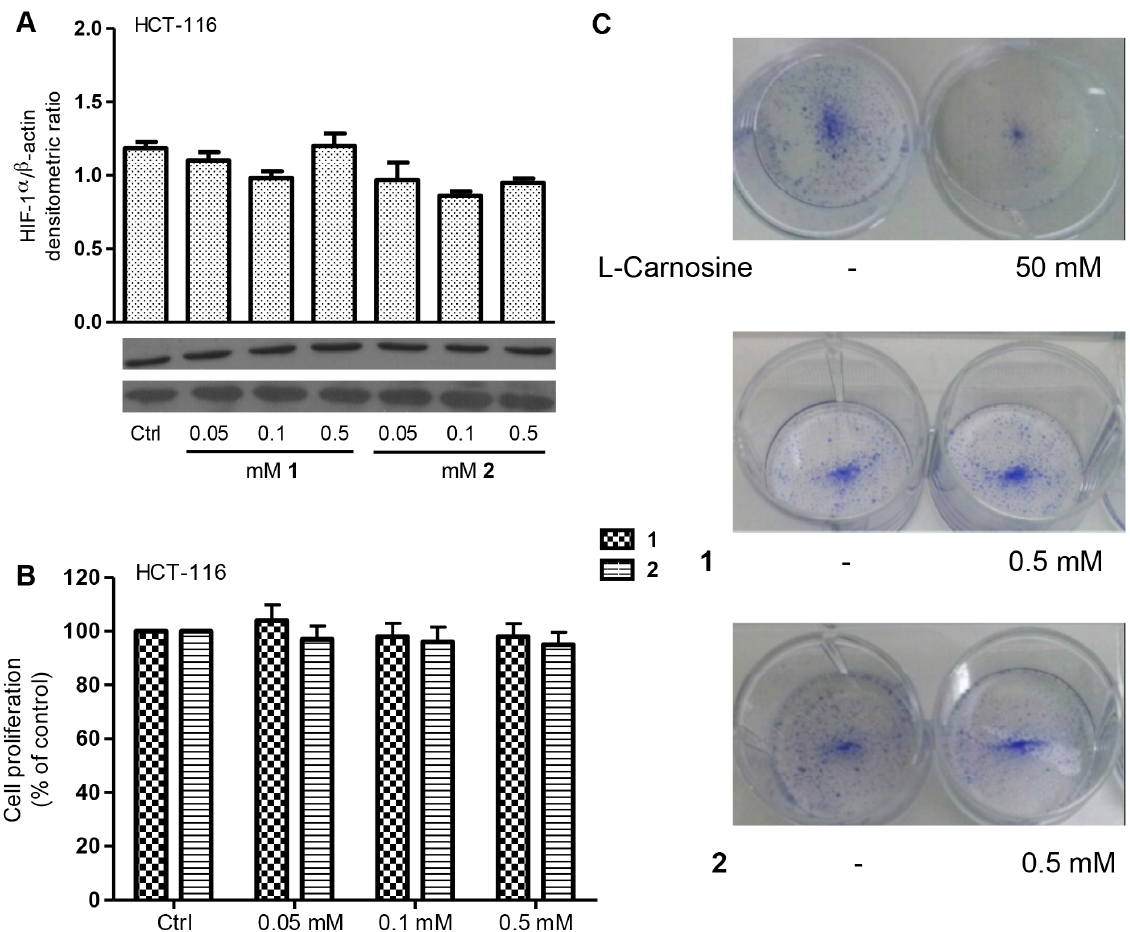
Figure 6. Compounds 1 and 2 have no effect on the HIF-1 a protein level and cell proliferation in HCT-116. (A) Western blotting analysis of the total protein extracts from HCT-116 cells after treatment with compounds 1 and 2 probed with HIF-1 a and b -actin antibodies. Histograms report the densitometric values of HIF-1 a / b -actin ratio. The densitometric values represent the mean 6 SDs of three independent experiments; (B) the cell proliferation was measured by MTT assay in HCT-116 cells 24 h after treatment with compounds 1 and 2 . All values represent the mean 6 SDs of three independent experiments and are expressed as a percentage compared to 100% of control cells; (C) Clonogenic survival assay in HCT- 116 after treatment with L-carnosine (50 mM) or compounds 1 and 2 (0.5 mM) with respect to untreated